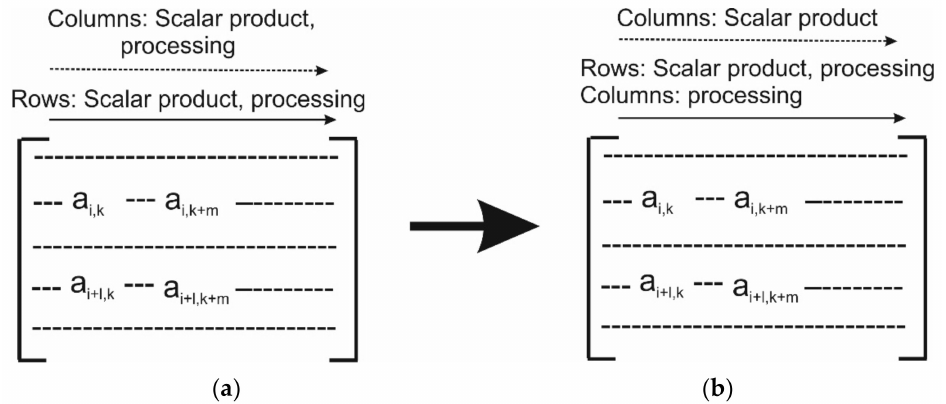
Figure 4. Obtaining a single-pass scheme for performing a basic transformation: ( a ) row-oriented transformation scheme; ( b ) single-pass transformation